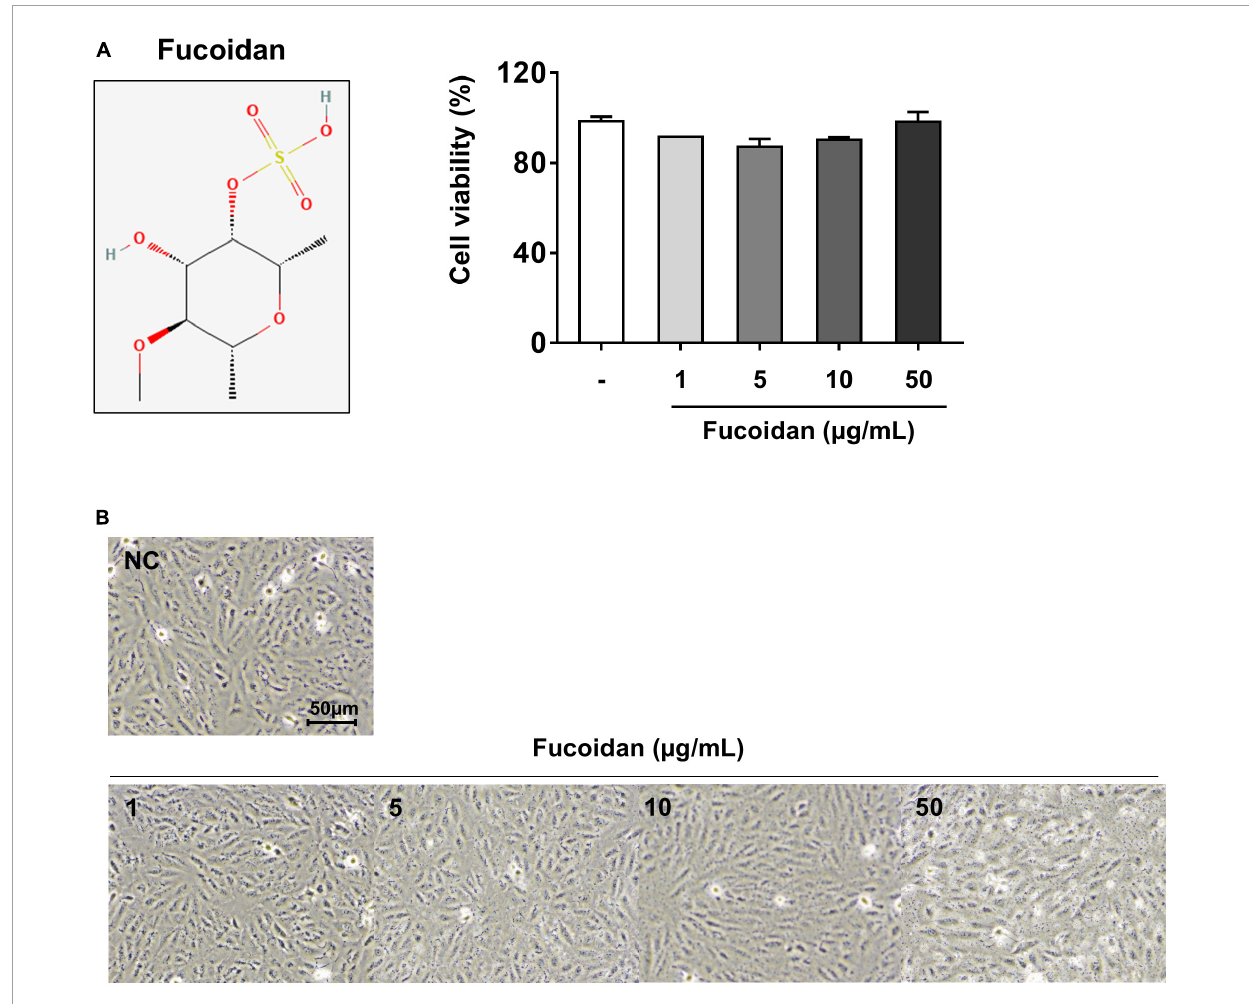
FIGURE5 Cell viability and morphology of fucoidan-treated ARPE-19 cells. ARPE-19 cells were treated with various fucoidan concentrations. (A) Cell viability and (B) cell morphology after treatment (1, 5, 10, or 50 µ g/mL) for 24 h. The values represent the mean ± SD of three independent